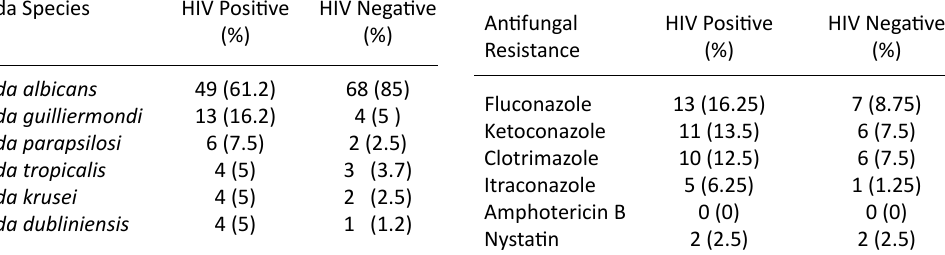
Table 4. Distribution of various species of Candida isolated from H.I.V. positive and H.I.V. Negative Patients Candida